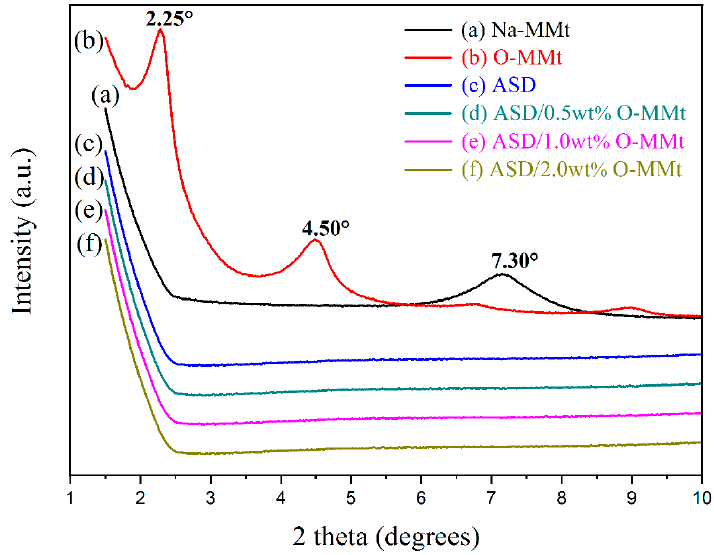
Figure 6. XRD patterns of ( a ) Na-MMt, ( b ) O-MMt, ( c ) ASD, ( d ) ASD/0.5 wt% O-MMt, ( e ) ASD/1.0 wt% O-MMt, and ( f ) ASD/2.0 wt% O-MMt.